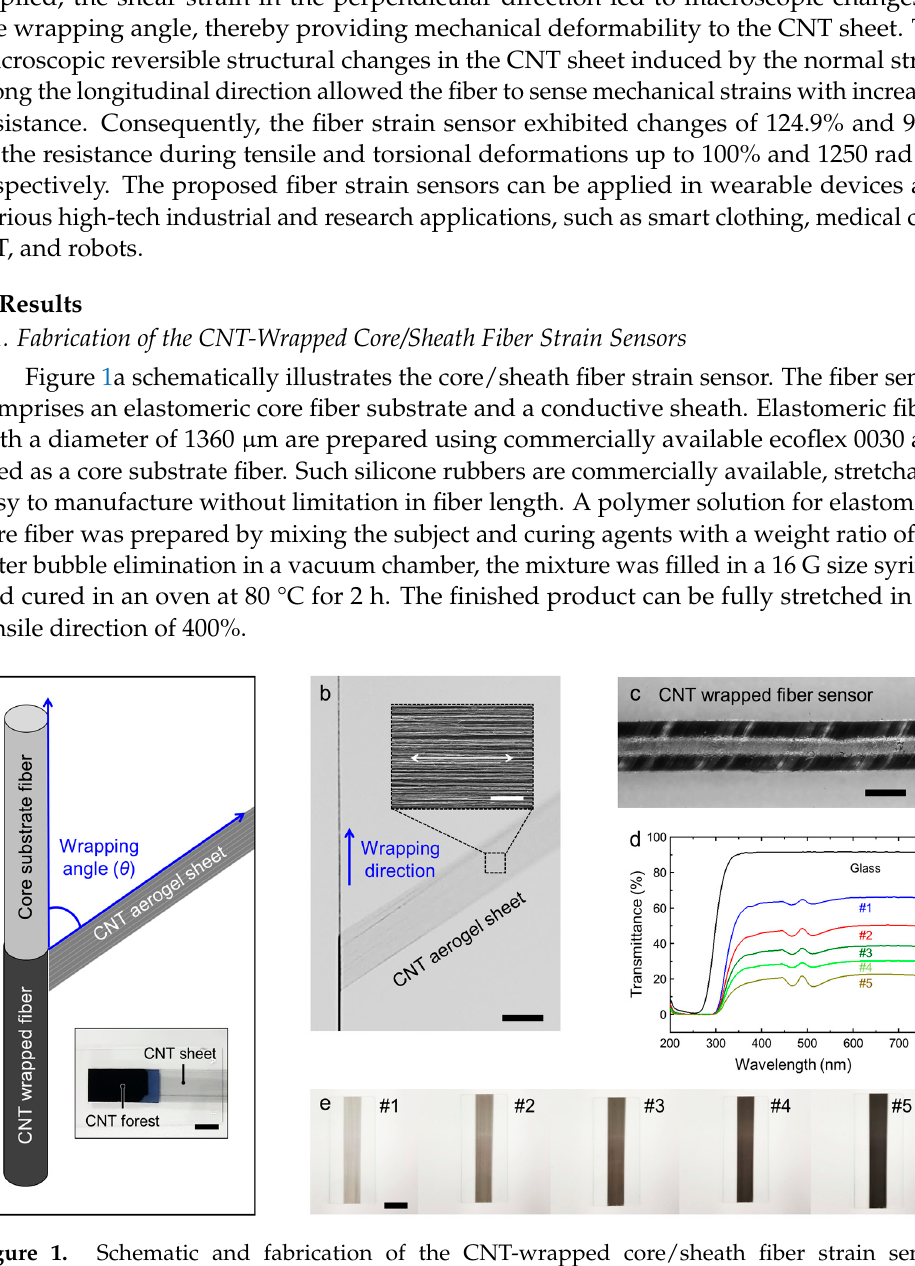
Figure 1. Schematic and fabrication of the CNT-wrapped core/sheath fiber strain sensor. ( a ) Sche- matic showing the CNT being wrapped on the core substrate fiber with a specific wrapping angle ( 𝜃 ). (Inset: photograph of the forest-drawn CNT aerogel sheet, scale bar = 5 mm). Photograph show- ing ( b ) the CNT being wrapped on the core substrate fiber, with the white arrow indicating the CNT alignment direction (scale bar = 1 cm) (Inset: scanning electron microscopy (SEM) image of forest- drawn well-aligned CNT aerogel sheet, scale bar = 50 μm ) and ( c ) CNT-wrapped fiber strain sensor with the wrapping angle on the surface. ( d ) Optical transmittance versus wavelength of stacked CNT sheet with one to five layers. ( e ) Photographs showing the dependence of the transparency on the number of layers in the stacked CNT sheet (scale bar = 1 cm).